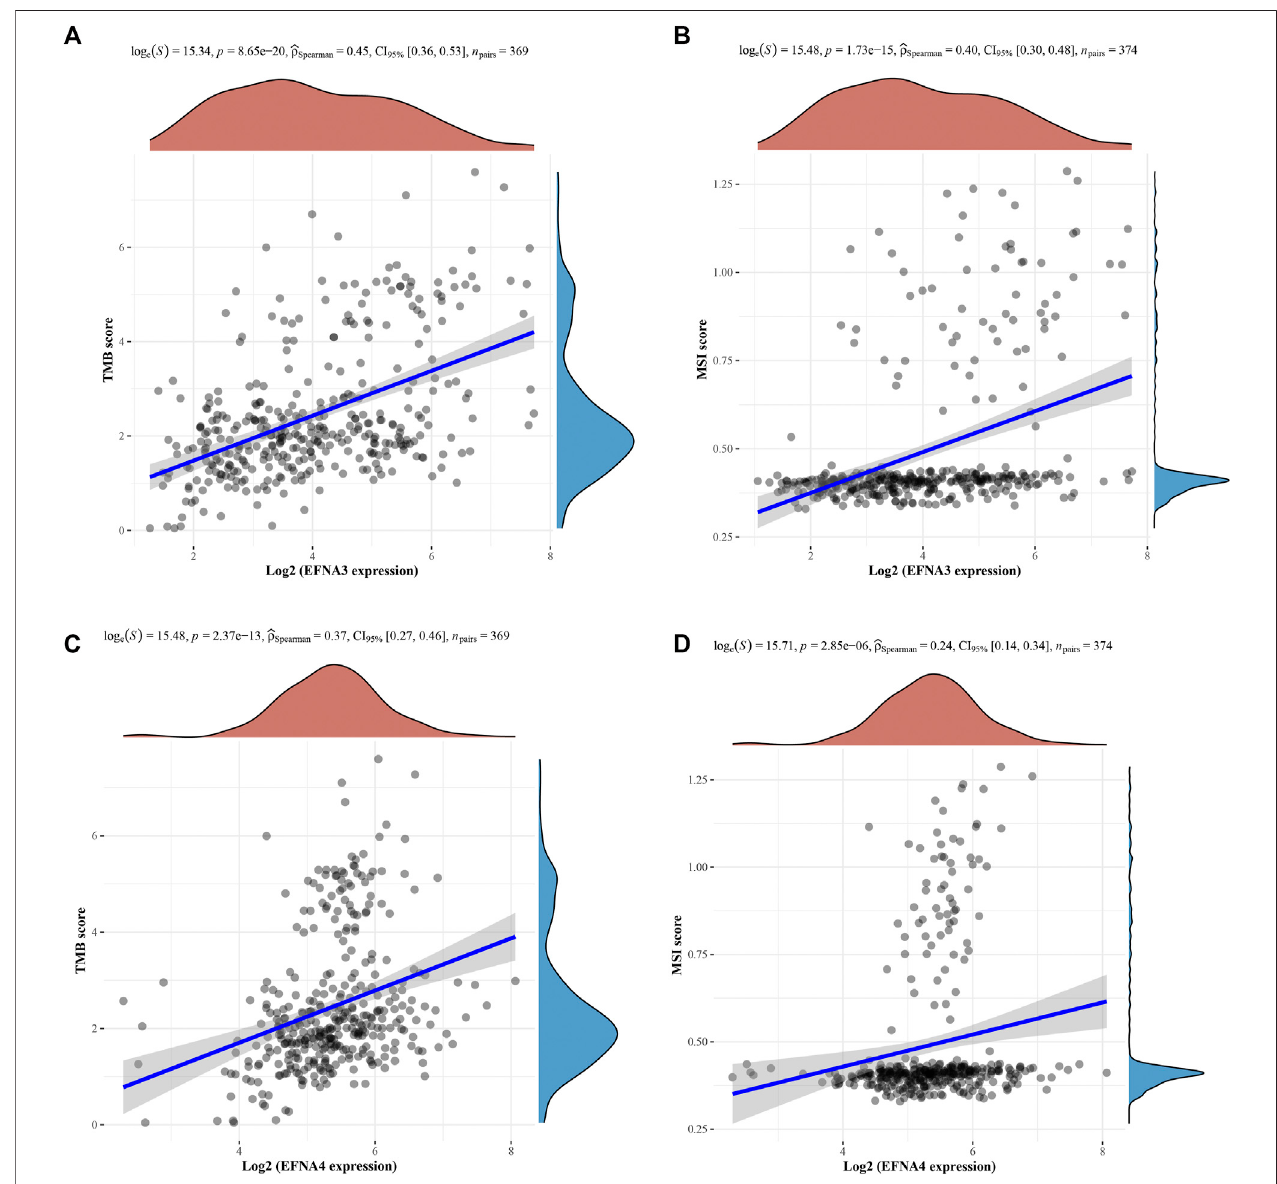
FIGURE 9 | Spearman correlation analysis of TMB/MSI and EFNA gene expression. The horizontal axis represents EFNA gene expression, and the vertical axis represents TMB/MSI score distribution. On the upper side is the red density curve showing the distribution trend of EFNA genes. On the right is a blue density curve showing trends in TMB/MSI fractions. (A) EFNA3 and TMB (B) EFNA3 and MSI (C) EFNA4 and TMB (D) EFNA4 and MSI.